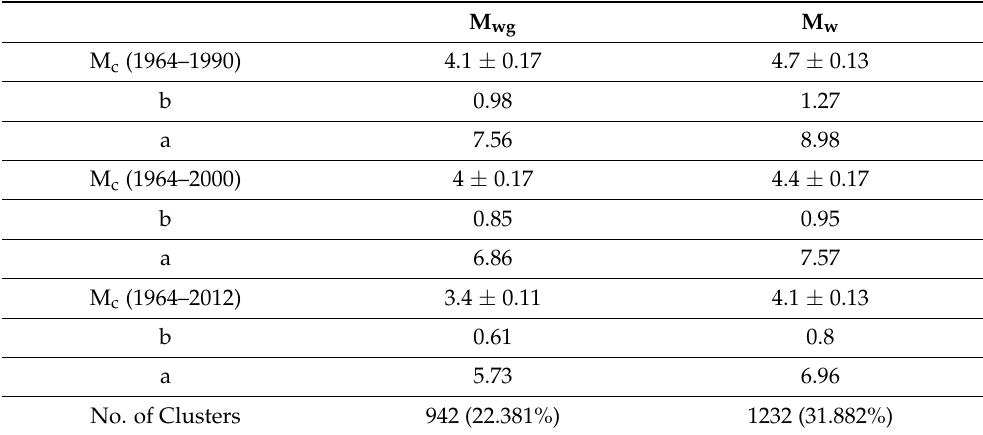
Table 5. Difference in seismicity parameters between M wg catalog and M w catalog for different time periods.